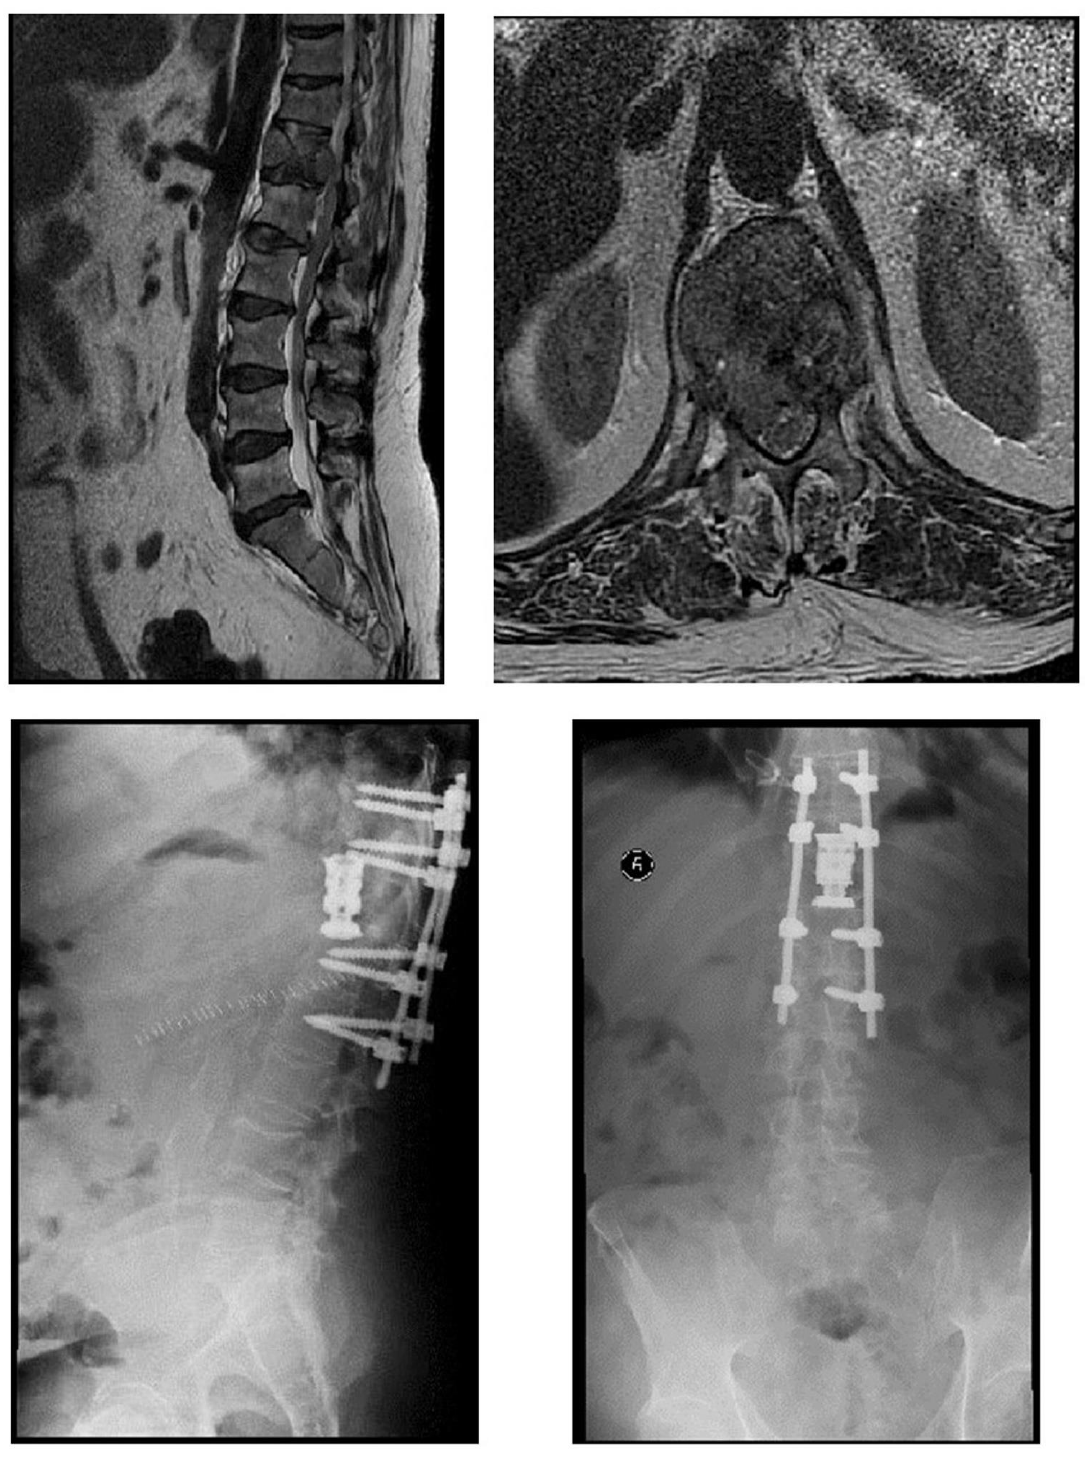
Figure 2. A 57-year-old patient presented to the ER with deterioration in neurological status in his lower limbs and loss of ability to ambulate. MRI sagittal and axial T2 studies revealed a metastatic lesion in D12 with mechanical pressure on his cord. Urgent surgery was performed with a double approach: a posterior approach for decompression of the cord, and stabilization with pedicular screws for two levels above and two levels below D12. Next, a thoracotomy was performed for a complete corpectomy of D12 and the utilization of a cage. After the surgery, the patient regained the ability to ambulate with complete recovery from neurological deterioration. A pathological specimen revealed a liver source for